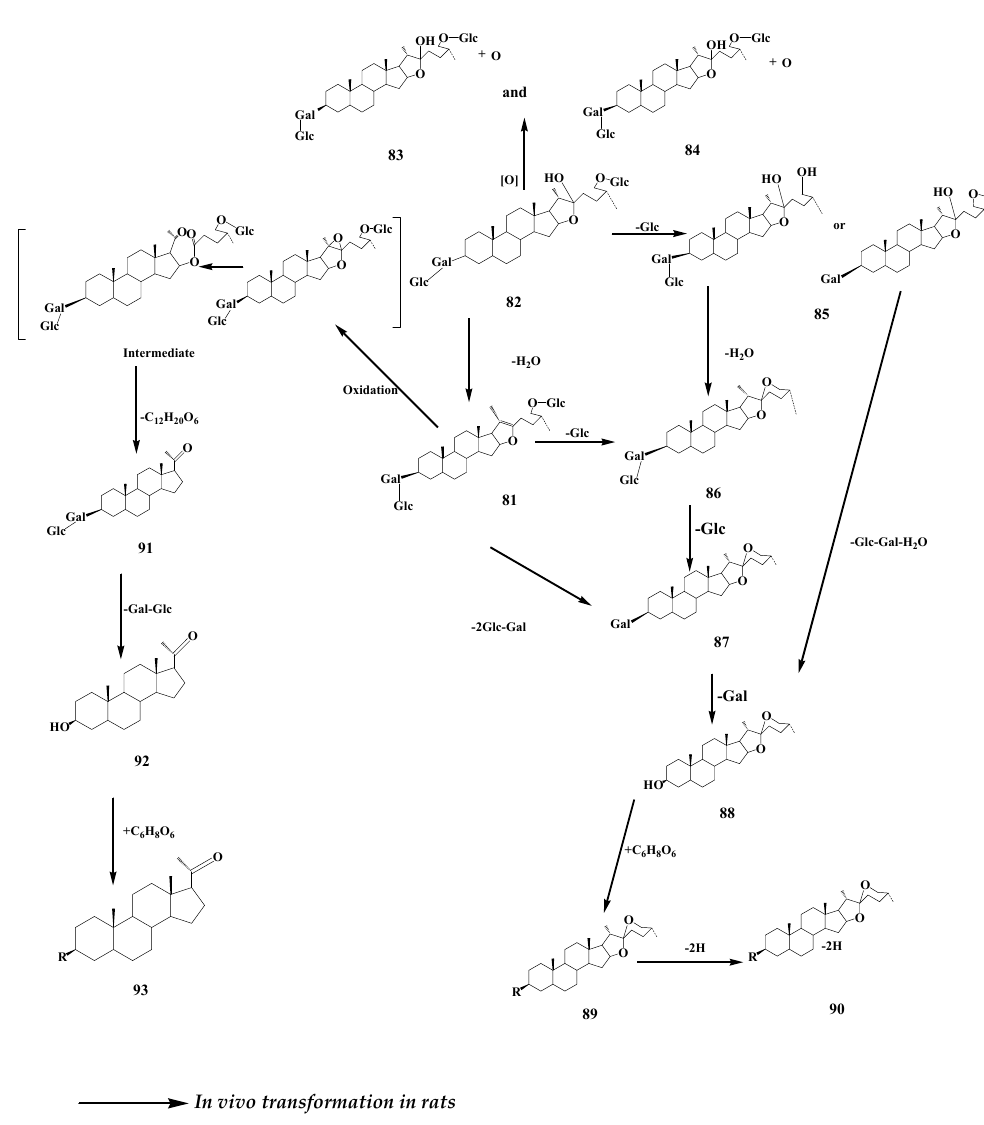
Figure 16. The proposed metabolic pathway of TB-II in rat [68].